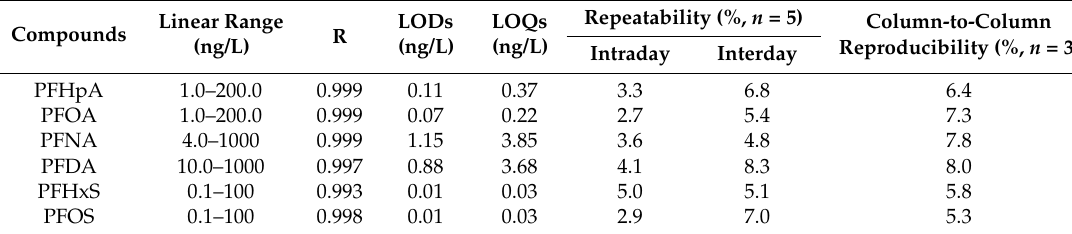
Table 1. Analytical data of the SPE method.